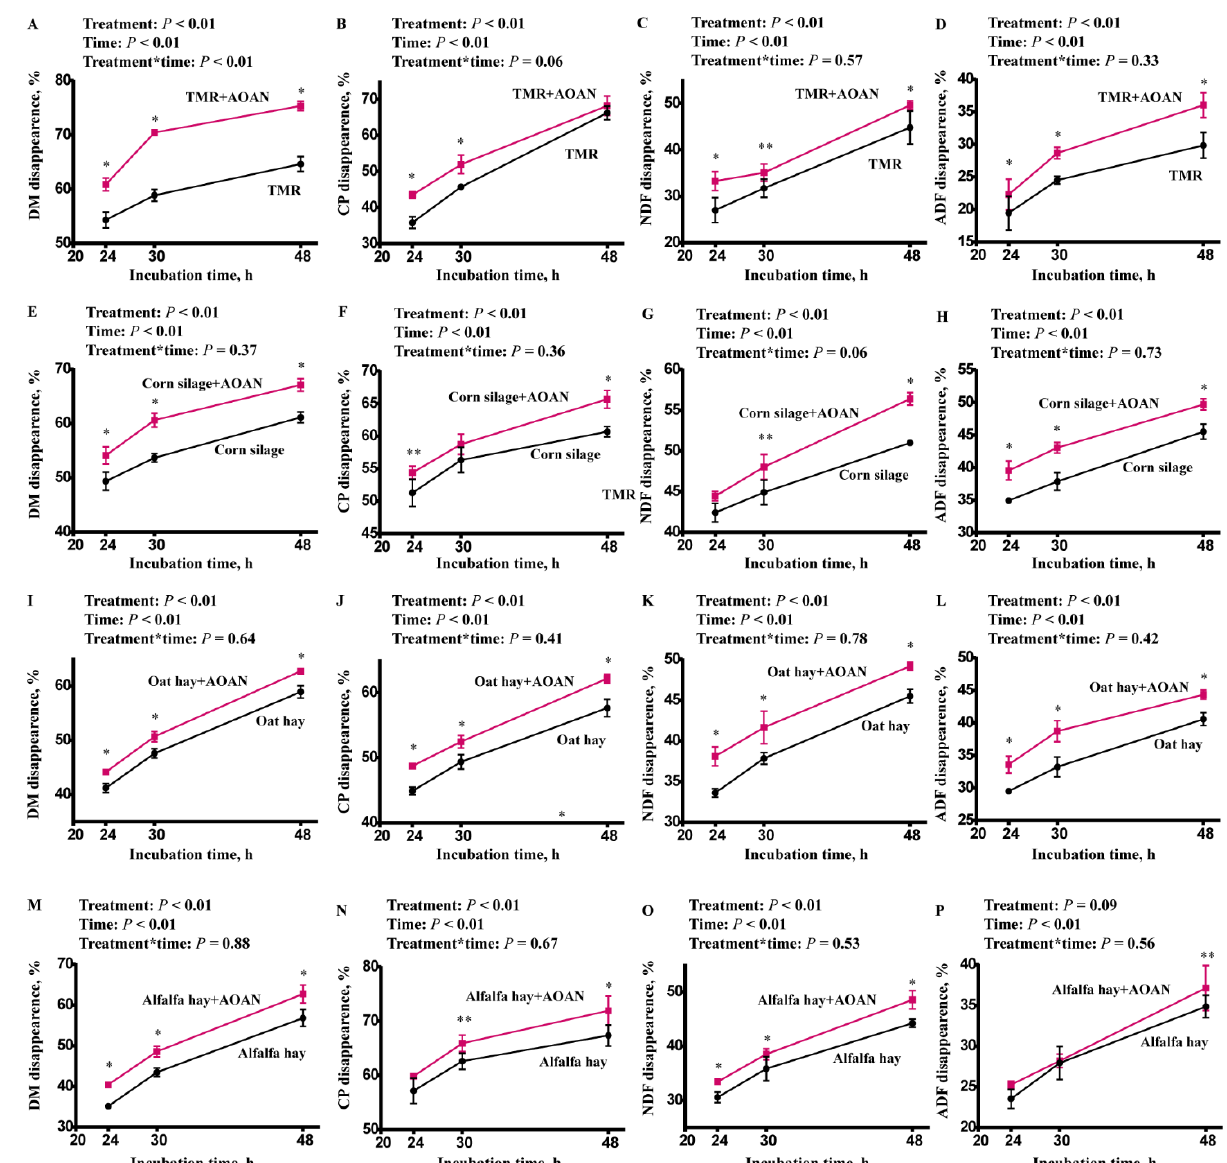
Figure 2. Effects of Aspergillus oryzae and Aspergillus niger co-cultivation fermentation extract on in vitro nutrient disappearance of total mixed ration ( A – D ), corn silage ( E – H ), oat hay ( I – L ), and alfalfa hay ( M – P ). AOAN indicates fermentation with Aspergillus oryzae and Aspergillus niger co-cultivation fermentation extract. *, p < 0.05; **, 0.05 < p < 0.1; TMR, total mixed ratio; DM, dry matter; CP, crude protein; NDF, neutral detergent fiber; ADF, acid detergent fiber.